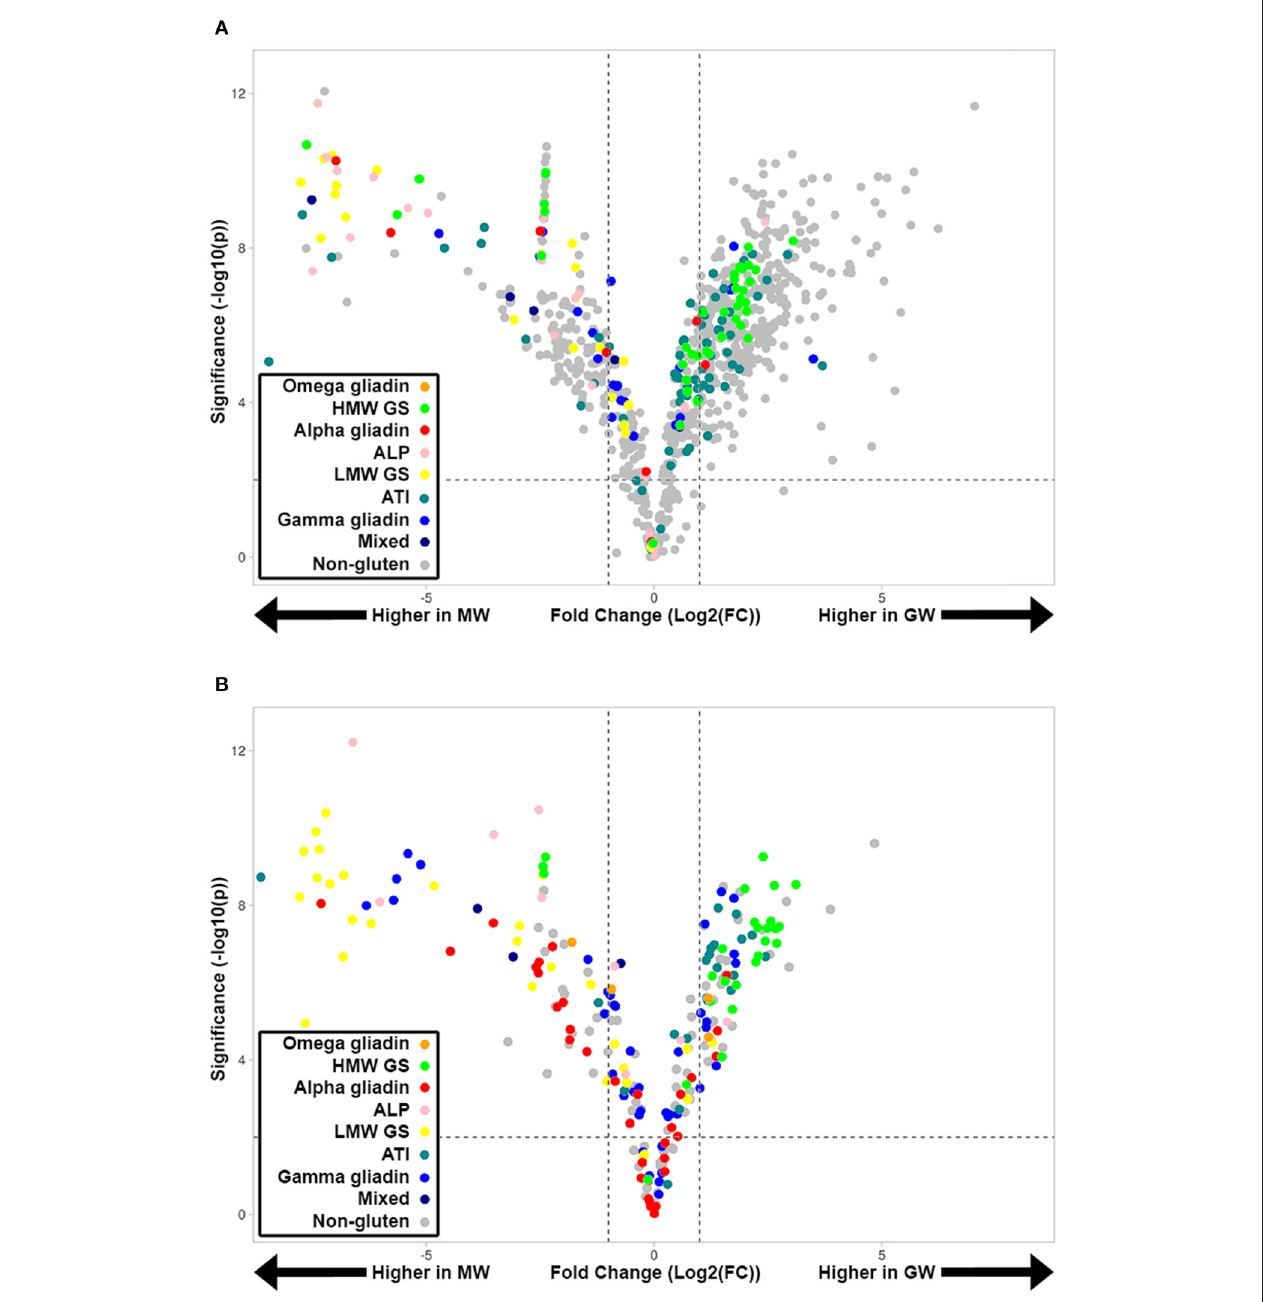
FIGURE 2 | Volcano plots showing quantified tryptic (A) and chymotryptic (B) peptides in GW and MW samples colored according to gluten group. A fold-change of 2 is indicated by the dashed vertical lines [Log 2 (FC) = ± 1]. Peptides above the horizontal dashed line have a significant change in abundance between GW and MW ( p -value < 0.01 [–log 10 ( p ) >